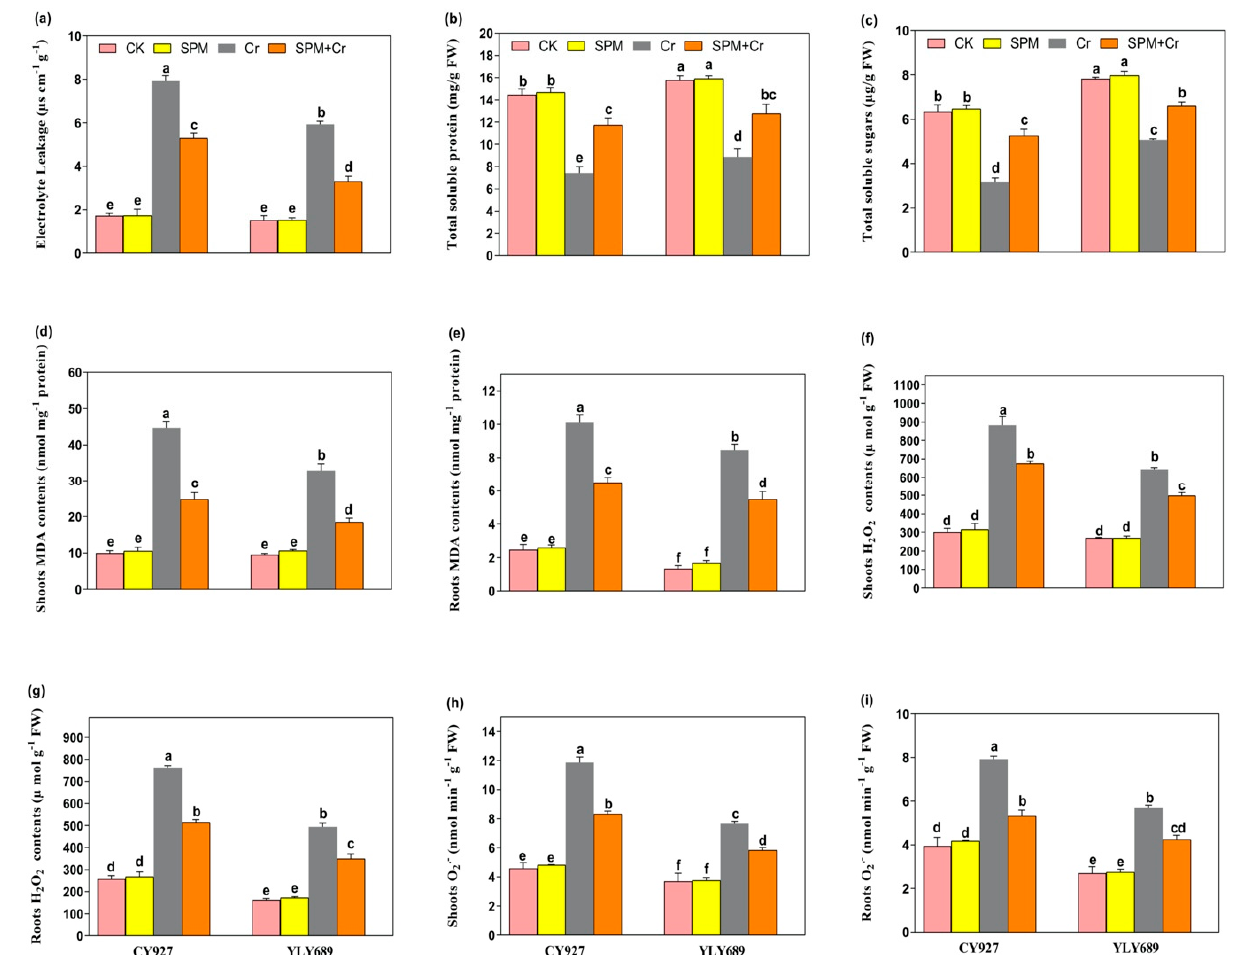
Figure 2. Effects of seed primed SPM on ( a ) electrolyte leakage (EL), ( b ) total soluble proteins, ( c ) total soluble sugar (TSP), ( d ) MDA contents in shoots, ( e ) MDA contents in roots, ( f ) H 2 O 2 , contents in shoots ( g ) H 2 O 2 , contents in roots ( h ) O 2 •− contents in the shoots and ( i ) O 2 •− contents in the roots